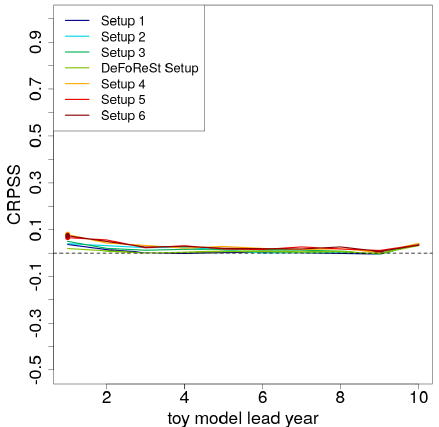
Figure 9. CRPSS of different toy model setups with low potential predictability ( η = 0 . 2, colored lines) post-processed with boosted recalibration. The associated toy model setups post-processed with DeFoReSt are used as reference for the skill score. CRPSS larger zero implies boosted recalibration performing better than DeFoR- eSt. Colored dots indicate lead years with either significant positive or negative values based on a 95% confidence interval from boot- strapping (100